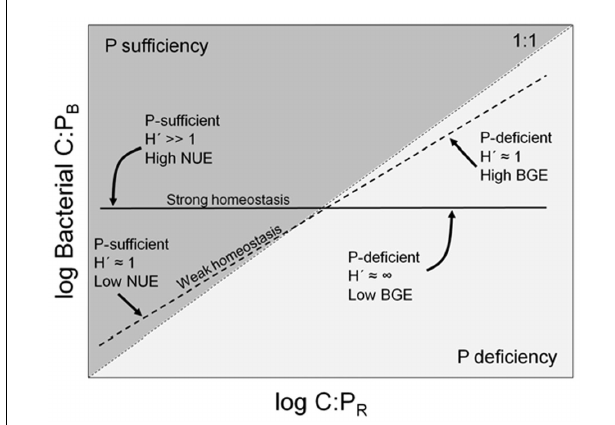
FIGURE 1 | Conceptual model of C:P stoichiometry in heterotrophic bacteria modified from Sterner and Elser (2002). The dotted line represents a 1:1 relationship between resource C:P and bacterial C:P.The horizontal solid line indicates strict homeostatic regulation of C:P by bacteria ( H (cid:3) (cid:4) 1) and the dashed line indicates weak homeostatic control of C:P by bacteria ( H (cid:3) ≈ 1). BGE, bacterial growth efficiency and NUE, nutrient use